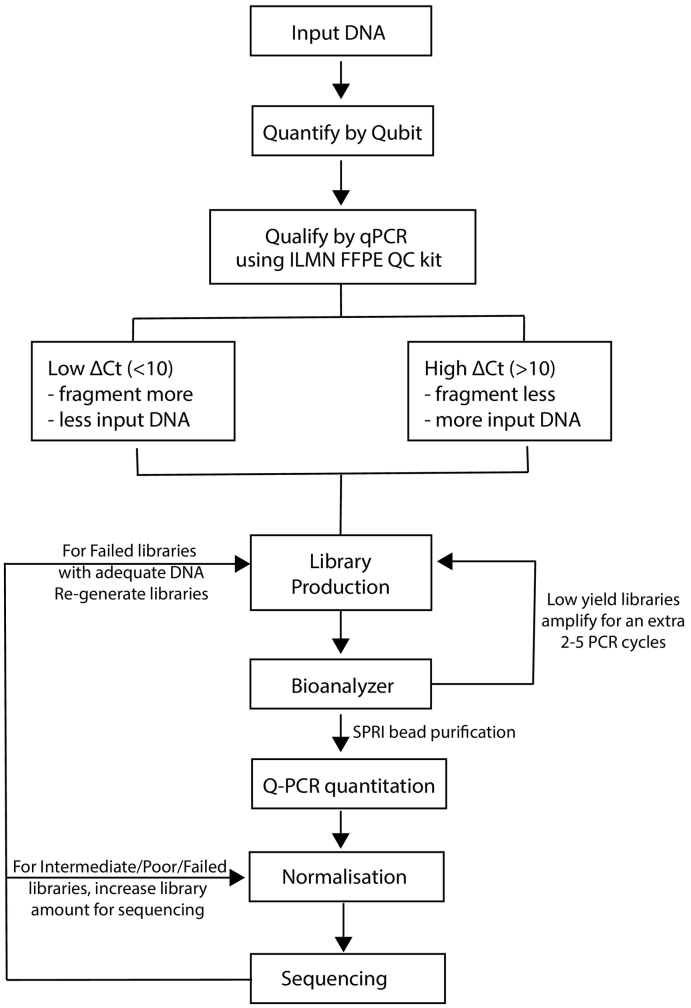
Overall Design: Schematic showing the workflow to ensure successful shallow whole genome sequencing (sWGS) libraries.